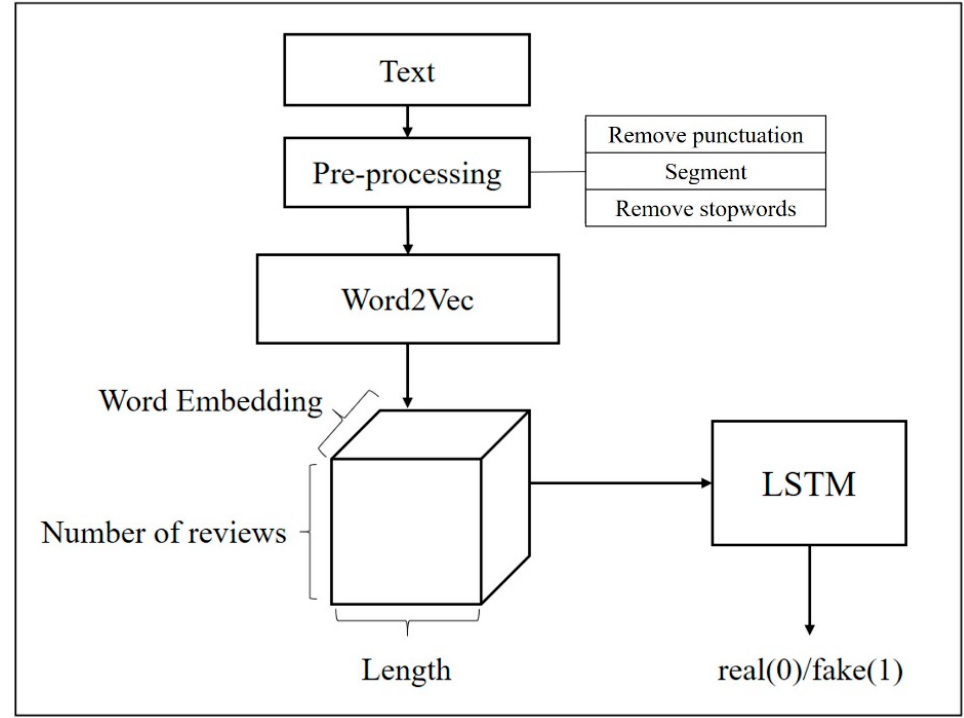
Figure 6. Architecture of the Word2Vec + LSTM model.